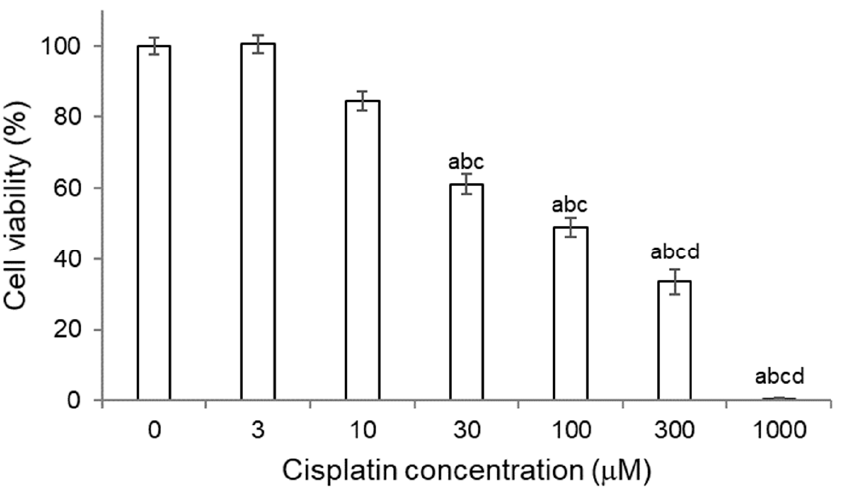
Figure 6. Titration of cisplatin cytotoxicity for 18 h of treatment in NRK-52E cells. Cell viability was determined using the MTT assay. Values are expressed as the mean ± SEM. Significant differences ( p < 0.05): a vs. 0 μ M, b vs. 3 μ M; c vs. 10 μ M; d vs. 30 μ M.